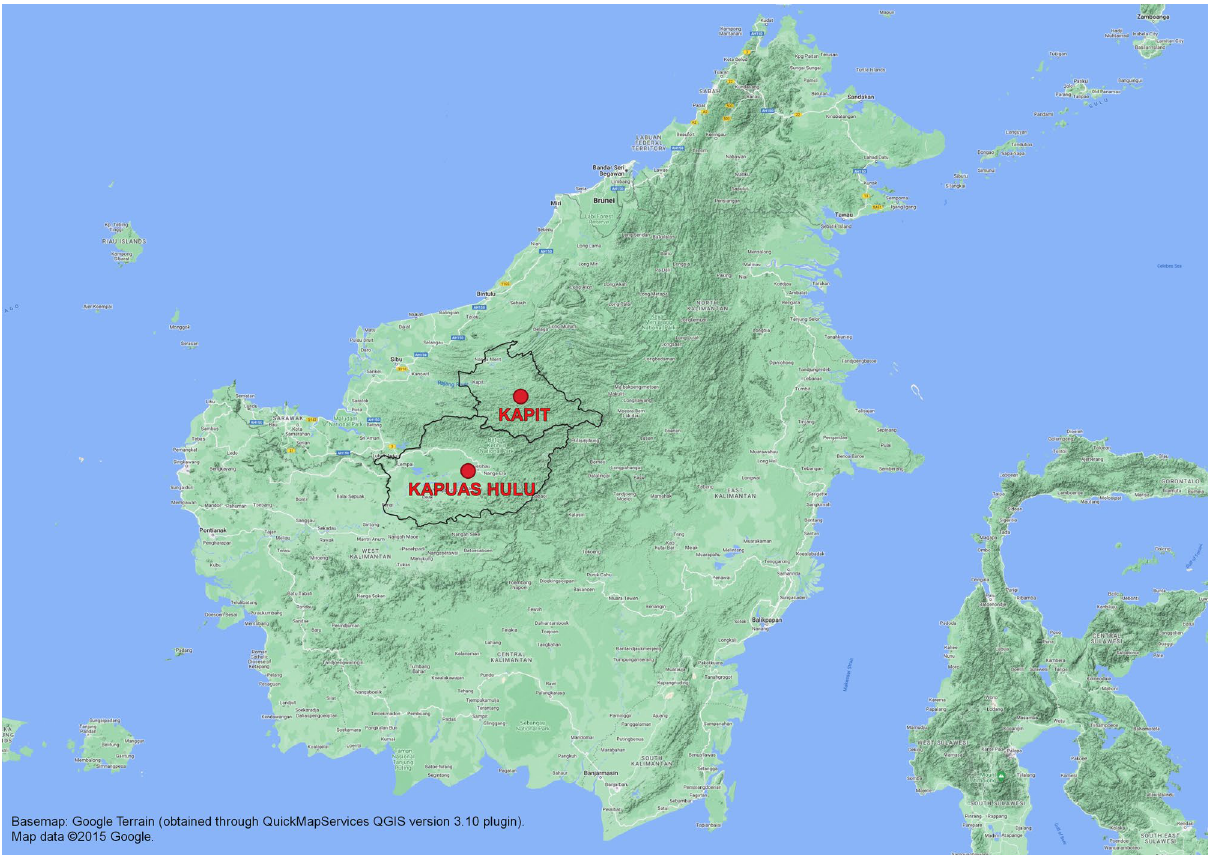
Figure 1. Map of the island of Borneo showing that the Kapit Division in Sarawak, Malaysia, is situated across the northern border of Kapuas Hulu District, West Kalimantan,